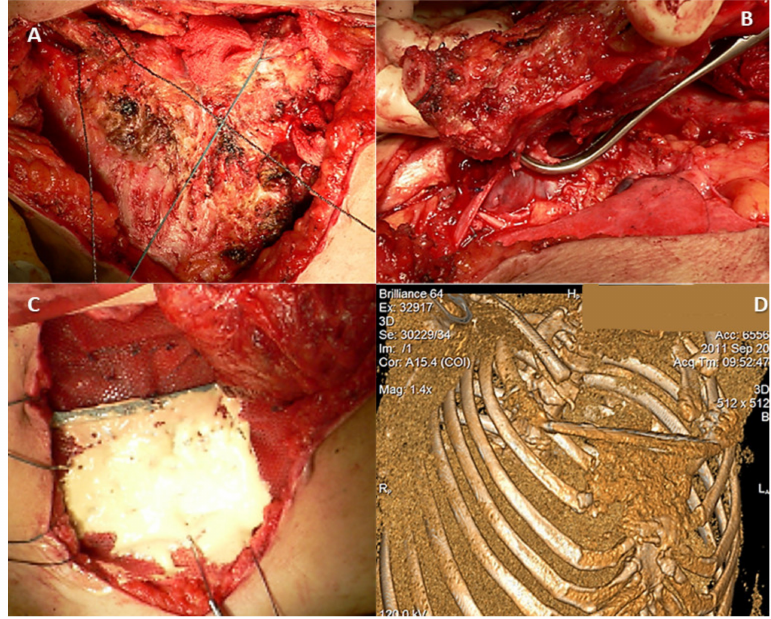
Figure 3. Intraoperative aspect of a 64-year-old patient diagnosed with a manubrial tumor. A Gigli wire saw ( A ) was used for en bloc bilateral resection of the medial third of the clavicles, the cartilaginous portion of the first rib, and the manubrium ( B ). ( C ) Polypropylene mesh and Kryptonite cementum were used for rigid anterior chest wall reconstruction. ( D ) A 3D-CT scan reconstruction at three months after surgery shows the